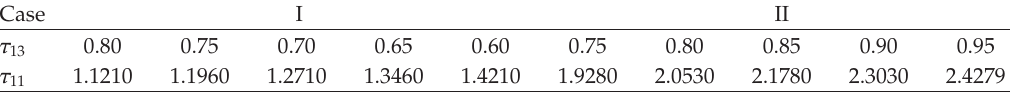
ff erent values of τ ff erent case. 11 of Example 5.1 for di 12 in a di